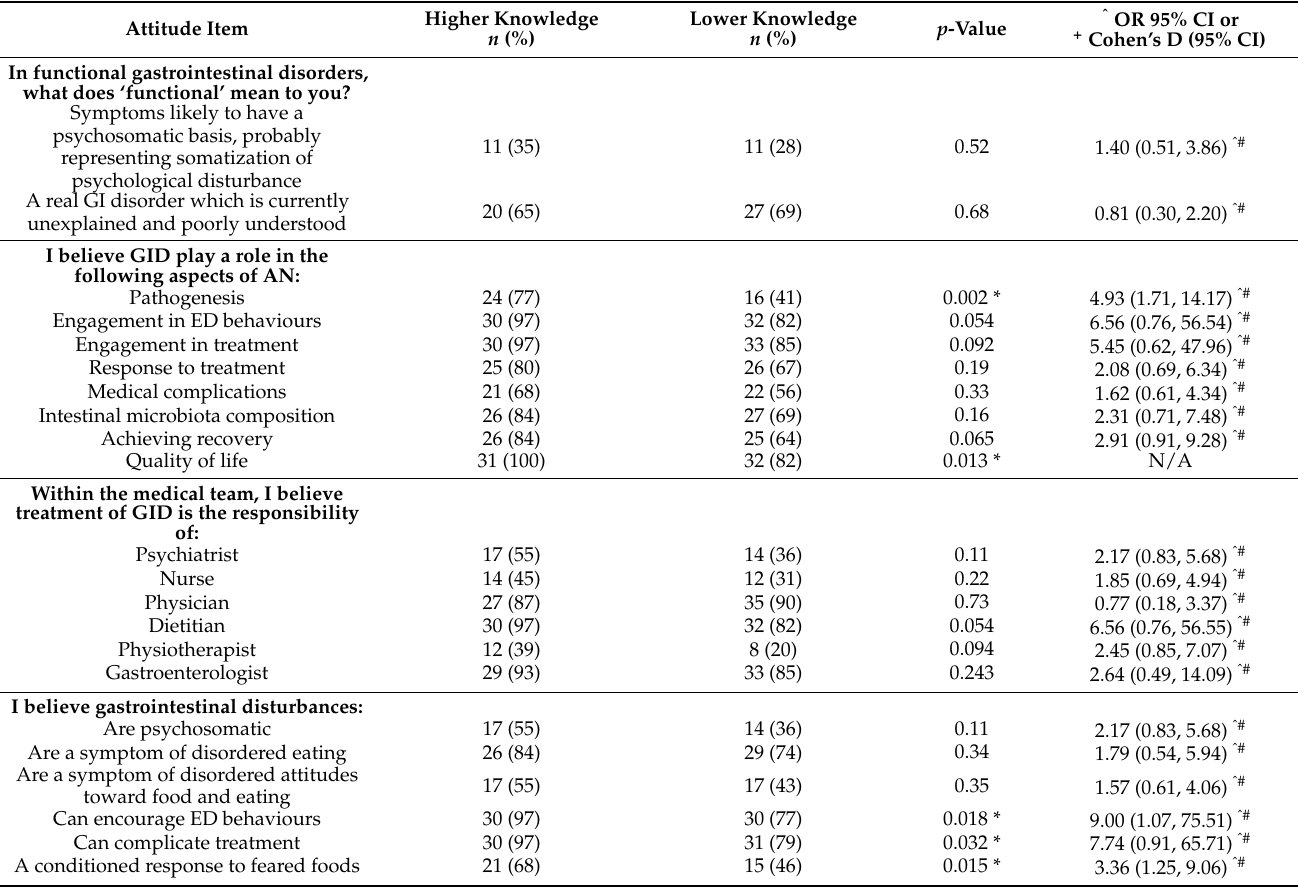
Table 2. Attitudes of dietitians with higher ( n = 31) and lower ( n = 39) knowledge of gastrointestinal disturbances in anorexia